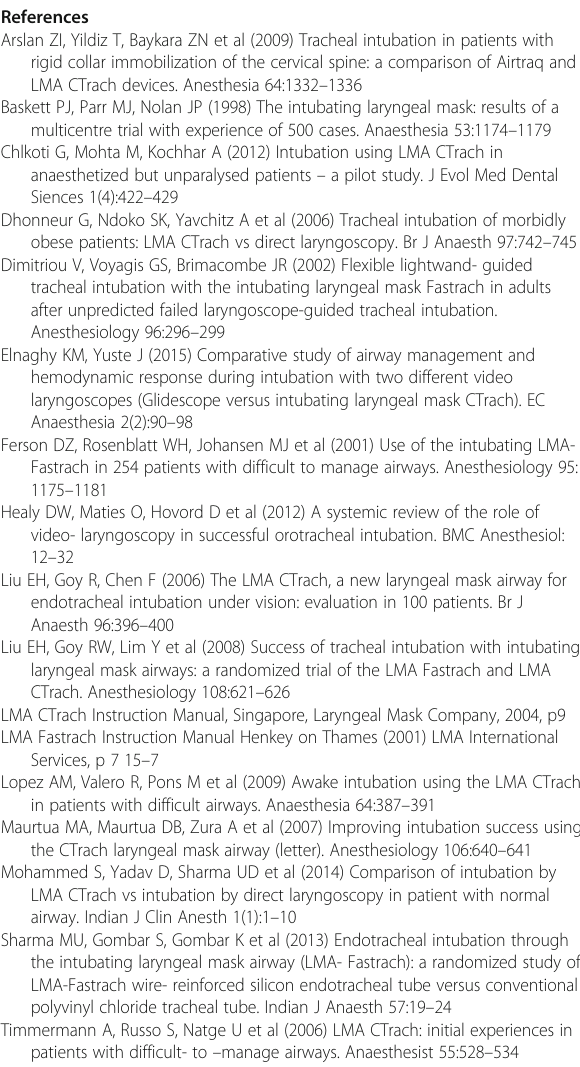
Fastrach group CTrach group ( n = 40) ( n =